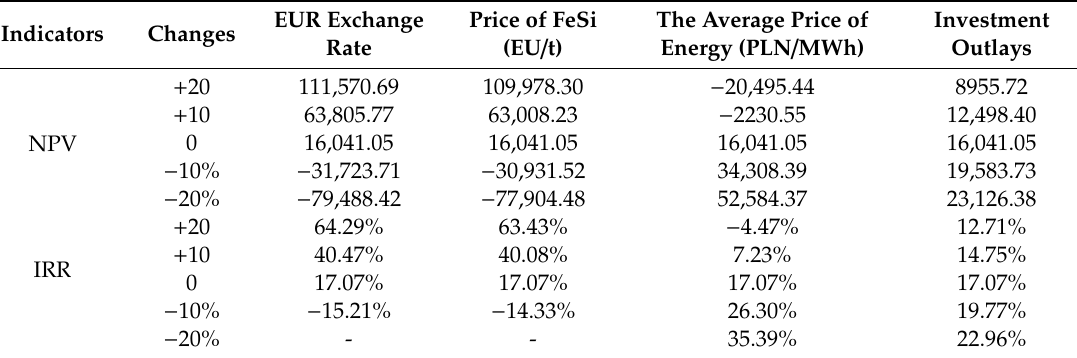
Table 2. NPV and IRR sensitivity to the currency exchange rate.